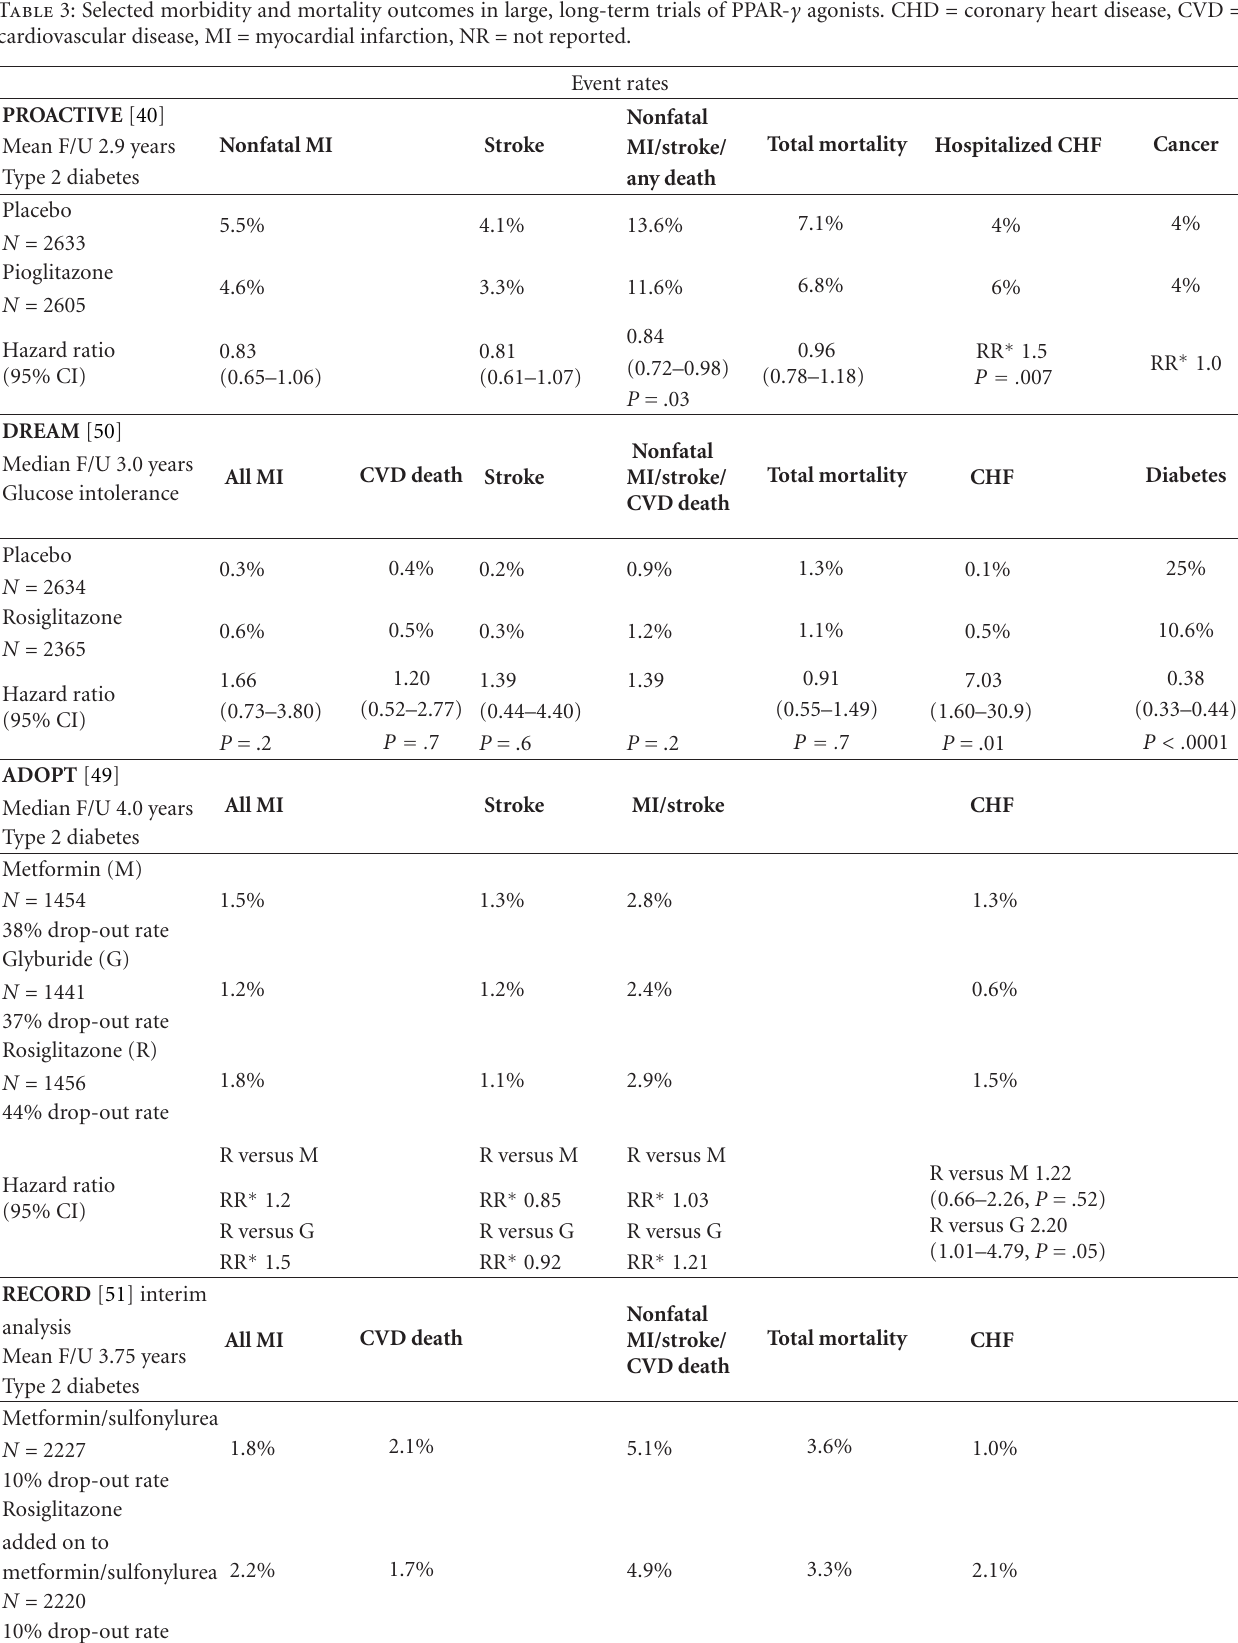
Table 3: Selected morbidity and mortality outcomes in large, long-term trials of PPAR- γ agonists. CHD = coronary heart disease, CVD = cardiovascular disease, MI = myocardial infarction, NR = not